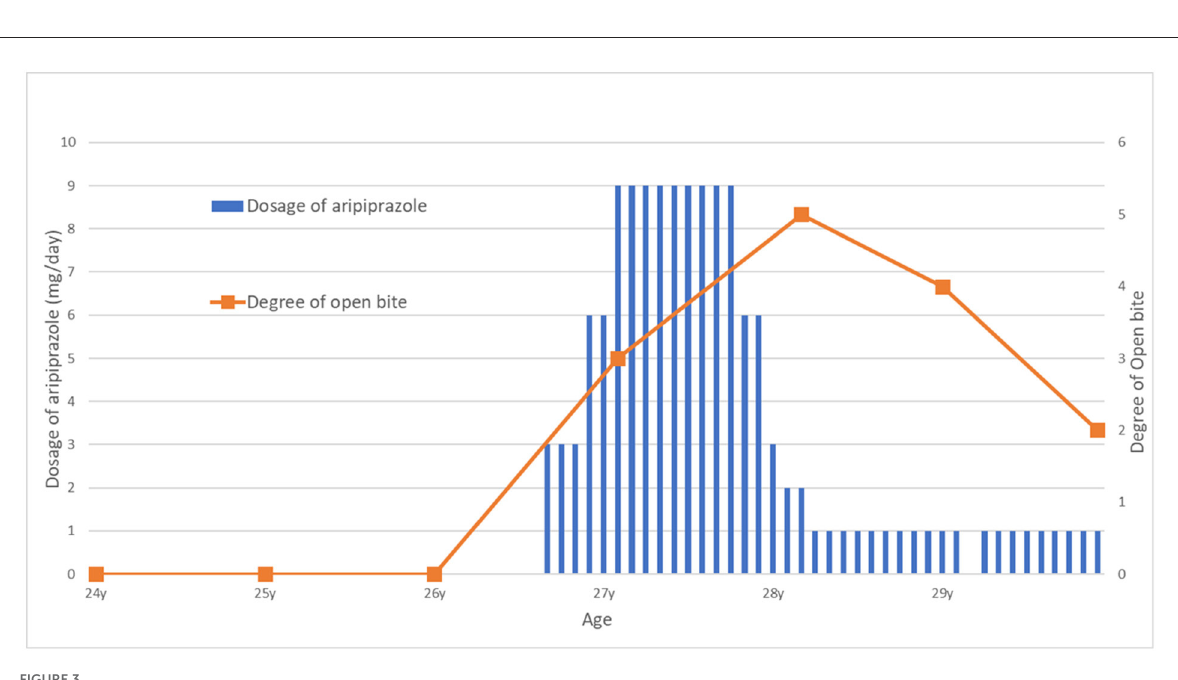
FIGURE3 Relationship between aripiprazole dosage and degree of open